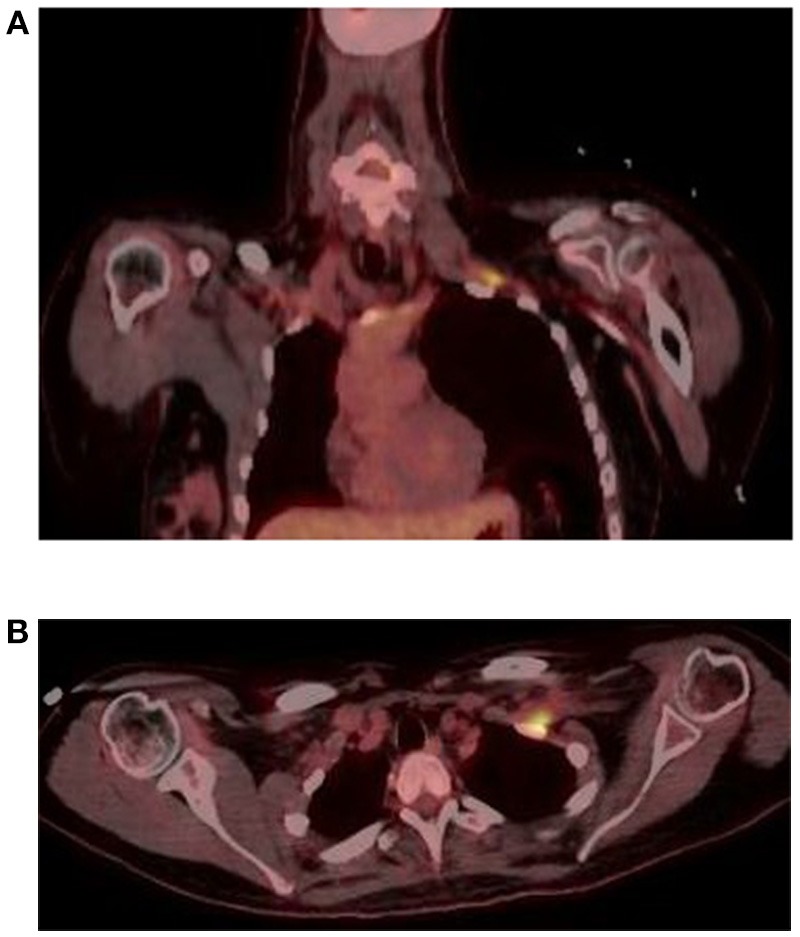
FDG PET coronal (A) and axial (B) sequences show focal hyperactivity at the left pectoral/subpectoral level adjacent to the first rib.